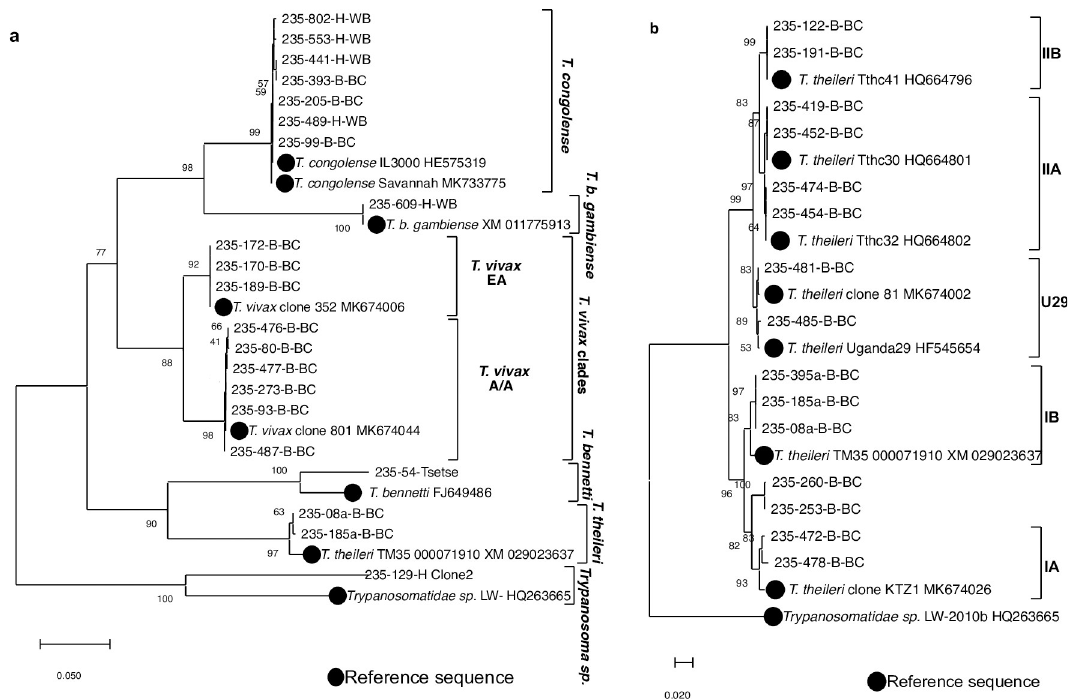
Fig 6. Neighbour-Joining trees based on alignments of gGAPDH sequences from trypanosome species detected in human, cattle, and tsetse in Southern Chad. They were calculated using complete gap deletion and tested with 700 bootstrap replications using MEGA X software (Kumar et al., 2018). a- gGAPDH nucleotide sequences of 21 representatives of different trypanosome species and 8 reference sequences retrieved from GenBank were aligned. b- gGAPDH nucleotide sequences of 15 representatives of T . theileri clades detected only in cattle samples and 8 reference sequences belonging to IA, IB, IIA, IIB and U29 T . theileri clades retrieved from GenBank were aligned. Evolutionary analyses involved 613 bp ( a ) and 563 bp ( b ) stretches. Abbreviations: EA, East Africa; A/A: